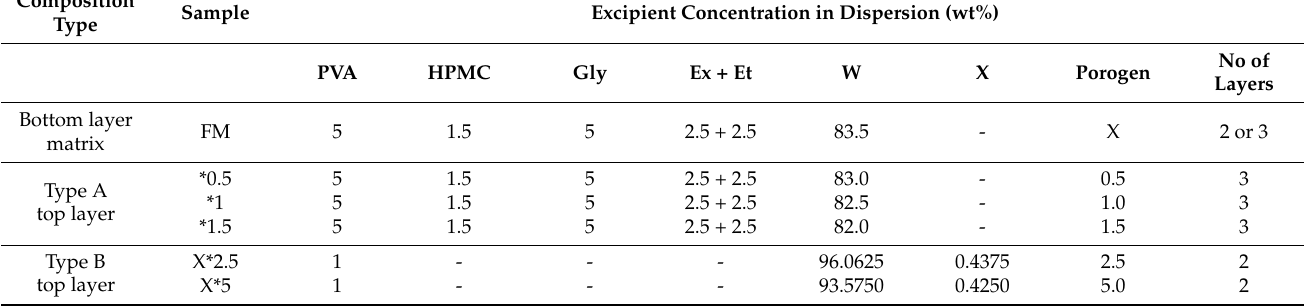
Table 1. Composition of print